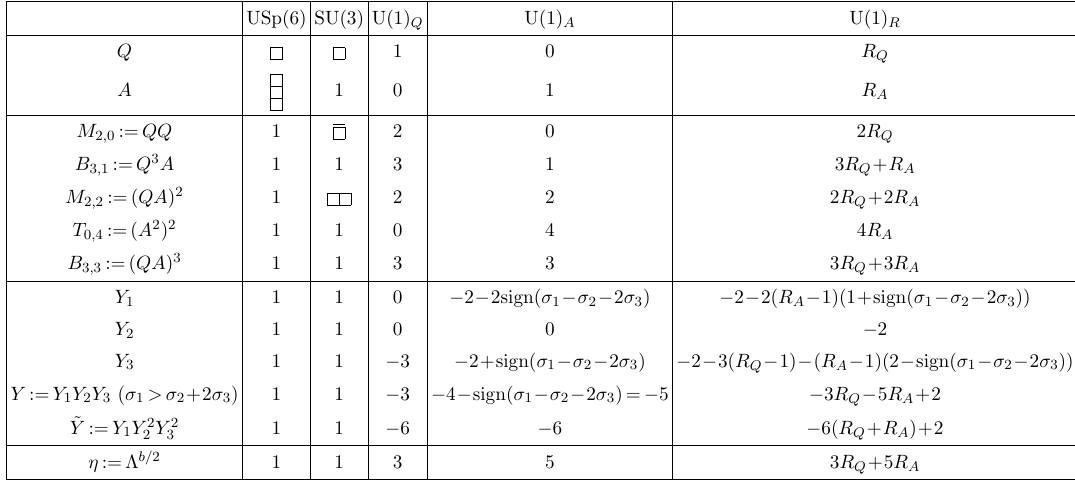
Table 4 . Quantum numbers of USp(6) with and 3